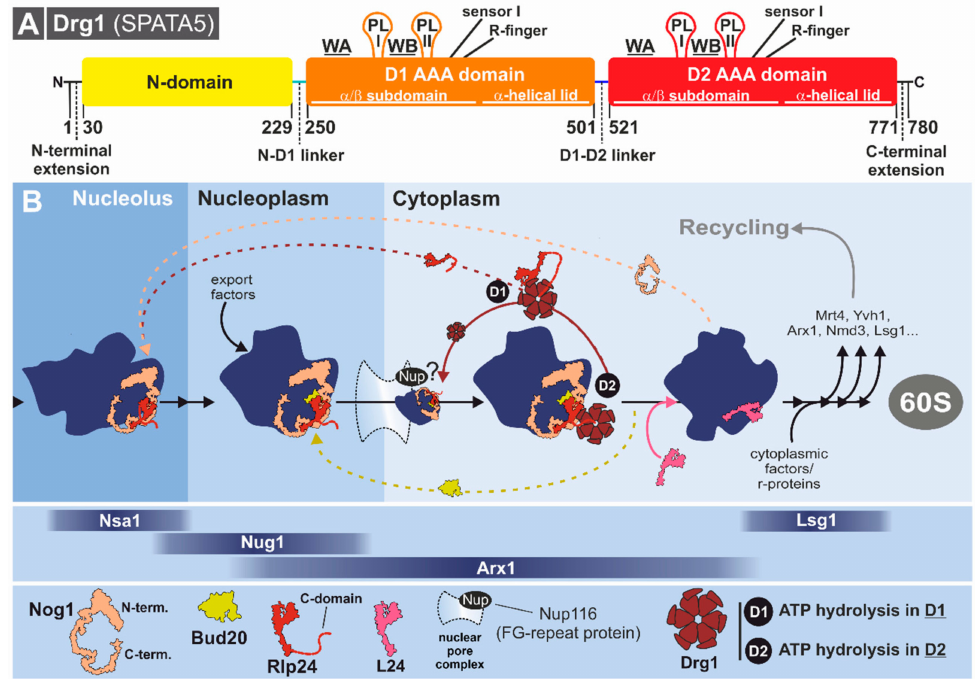
Figure 9. Structure and Function of Drg1. ( A ) Domain organization. The very N-terminal extension of Drg1 (spermatogenesis-associated 5 (SPATA5) in humans), which is absent in the related AAA-ATPase p97, is essential for stimulation of the ATPase activity by Rlp24. Both AAA domains of Drg1 are catalytically active and contain putative arginine finger motifs. The pore loop motifs are partially conserved but no data are available yet as to whether substrate processing of Drg1 involves full or partial threading of the substrate Rlp24. ( B ) Drg1 initiates the cytoplasmic pre-60S maturation cascade in yeast. Drg1 is recruited to pre-60S particles immediately after their export into the cytoplasm. The flexible C-terminal domain of the shuttling maturation factor Rlp24 recruits hexameric Drg1 via its NTD and stimulates ATP hydrolysis in both AAA domains of Drg1 to initiate the release process. ATP hydrolysis in the D2 domain releases Rlp24 from the pre-60S particle, while ATP hydrolysis in D1 subsequently dissociates the substrate Rlp24 from Drg1. Release of Rlp24 initiates cytoplasmic pre-60S maturation and is therefore required for all downstream events, including release and recycling of export and shuttling factors including Nog1, Bud20, and Mtr4. Rlp24 is recycled back into the nucleolus and its place at the ribosome is taken by the ribosomal protein L24 (eL24). Subsequently, the final r-proteins can be incorporated. FG-repeat: Phenylalanine-glycine